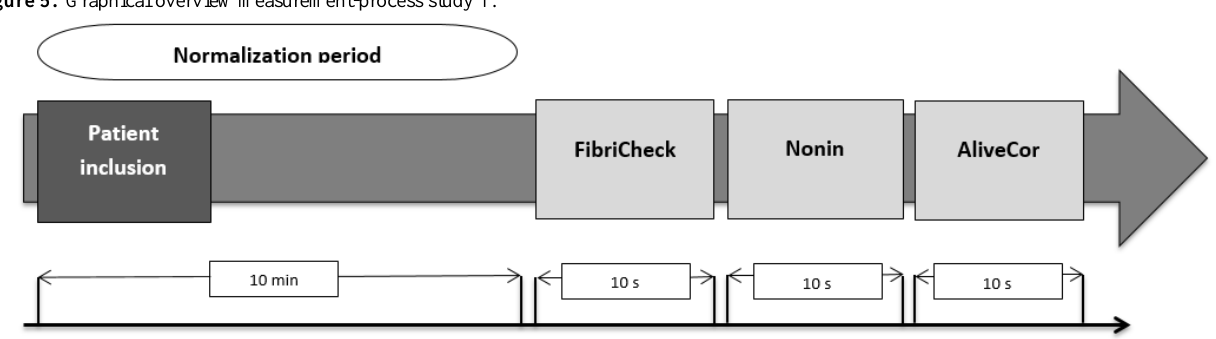
Figure 5. Graphical overview measurement-process study